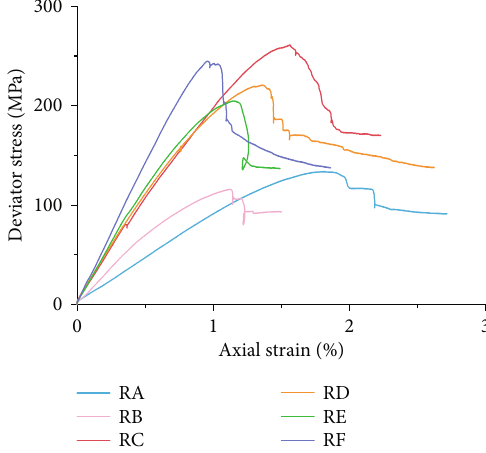
Figure 4: Stress – strain curves of mudstone and